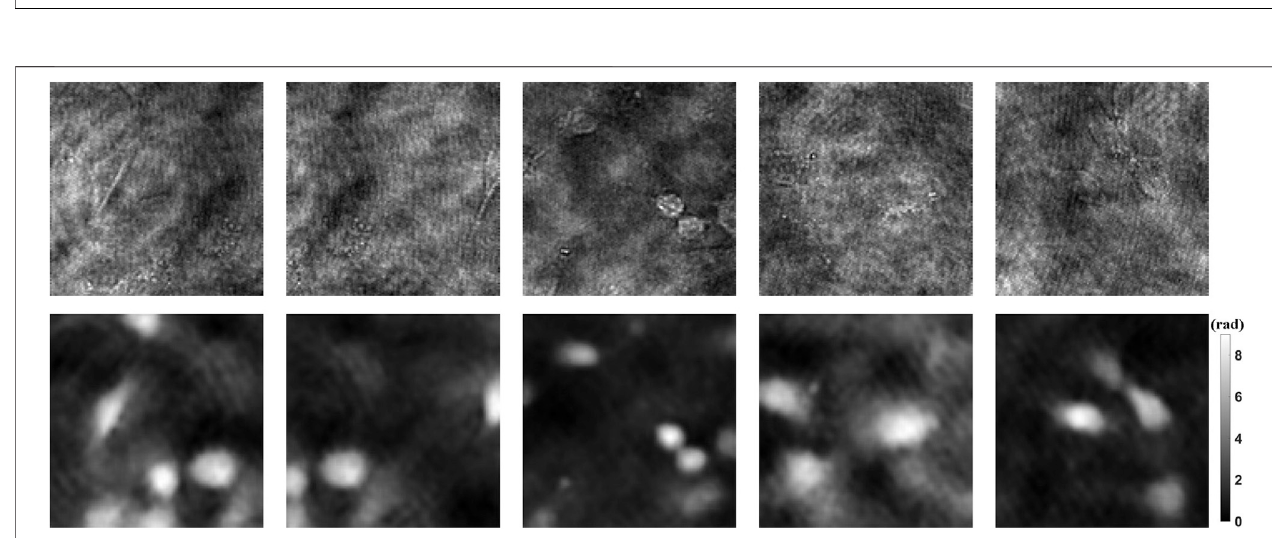
FIGURE 3 | Dataset examples. The upper part shows the holograms as input, and the lower part shows the phase results as ground truth.